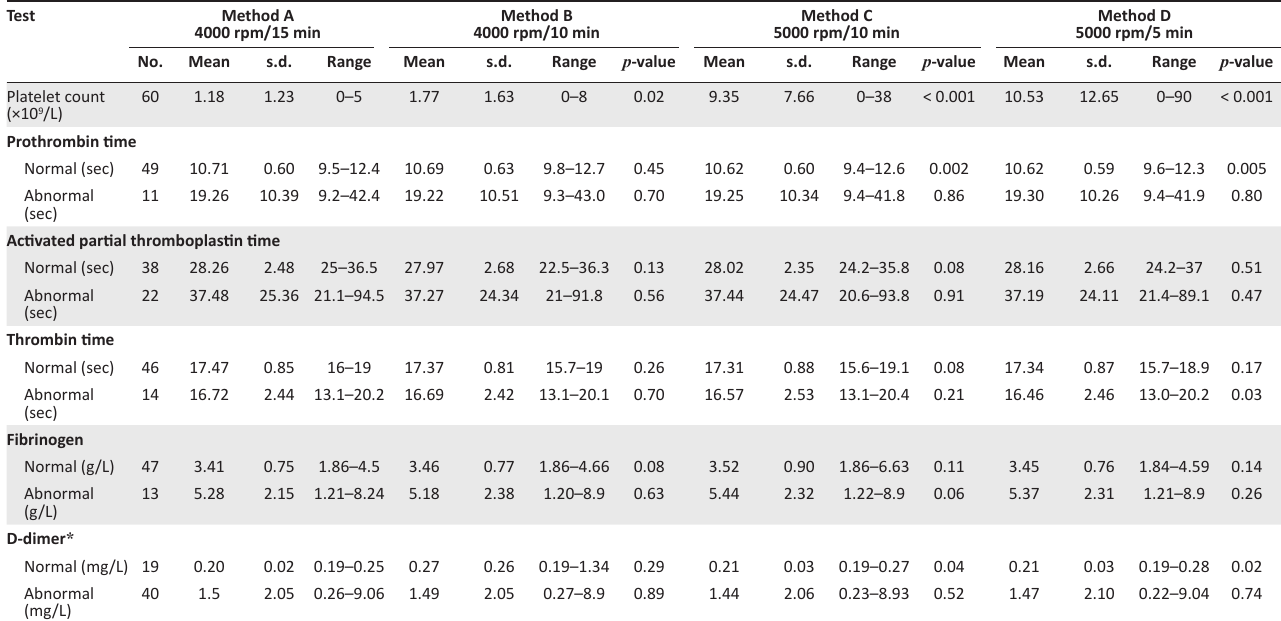
TABLE 3: Platelet counts, prothrombin time, activated partial thromboplastin time, thrombin time, fibrinogen and D-dimer levels using four centrifugation methods, Inkosi Albert Luthuli Central Hospital and King Edward VIII Hospital, Durban, KwaZulu-Natal, South Africa, September 2021 – November 2021.